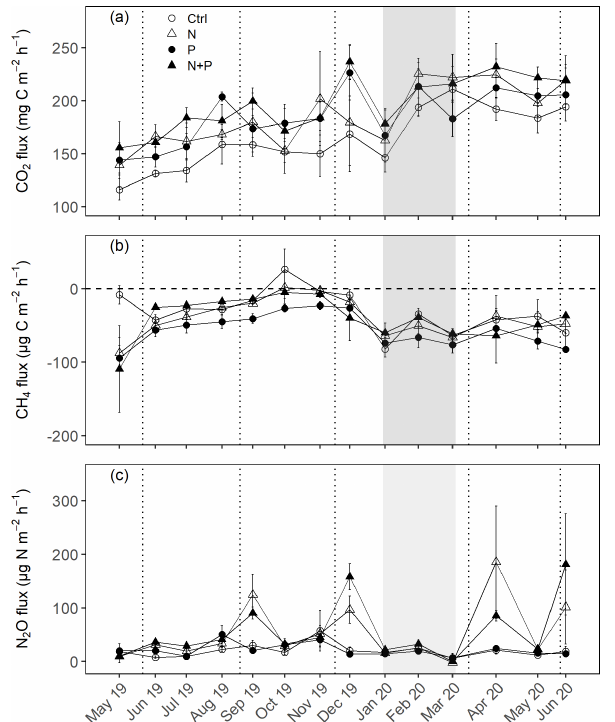
Figure 2. Mean ( ± SE; n = 4) WFPS (a) , soil temperature (b) , and nitrates (c) in the top 0.05m measured monthly (May 2019 to June 2020) from control (Ctrl), nitrogen (N), phosphorus (P), and N + P plots of the nutrient manipulation experiment. Vertical lines indicate the timing of each split dose of N (31.3kgNha − 1 ), P (12.5kgPha − 1 ), and N (31.3kgNha − 1 ) + P (12.5kgPha − 1 ) fer- tilization every 3 months. The gray shaded rectangle (in a , b , and c ) marks the beginning and end of the dry season (January and Febru- ary; monthly precipitation < 100mm), while panel (d) gives the daily precipitation (bars) and air temperature (line) between May 2019 and June 2020. Climatic data were obtained from a weather station installed at the Budongo Conservation Field Station, 2km from the location of the nutrient manipulation experiment in the Budongo Central Forest Reserve, northwestern Uganda.